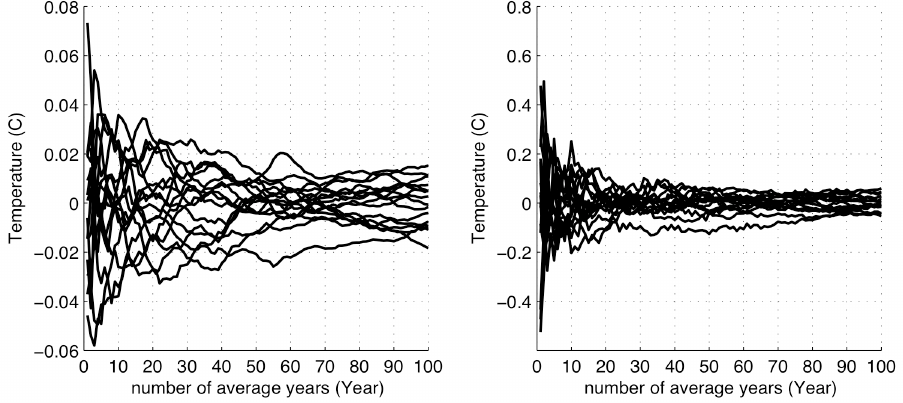
Figure 5. The evolution of maximum and minimum Global-SST (left) and Nino-SST 2 (right) deviation with the number of average years in climatology. 3